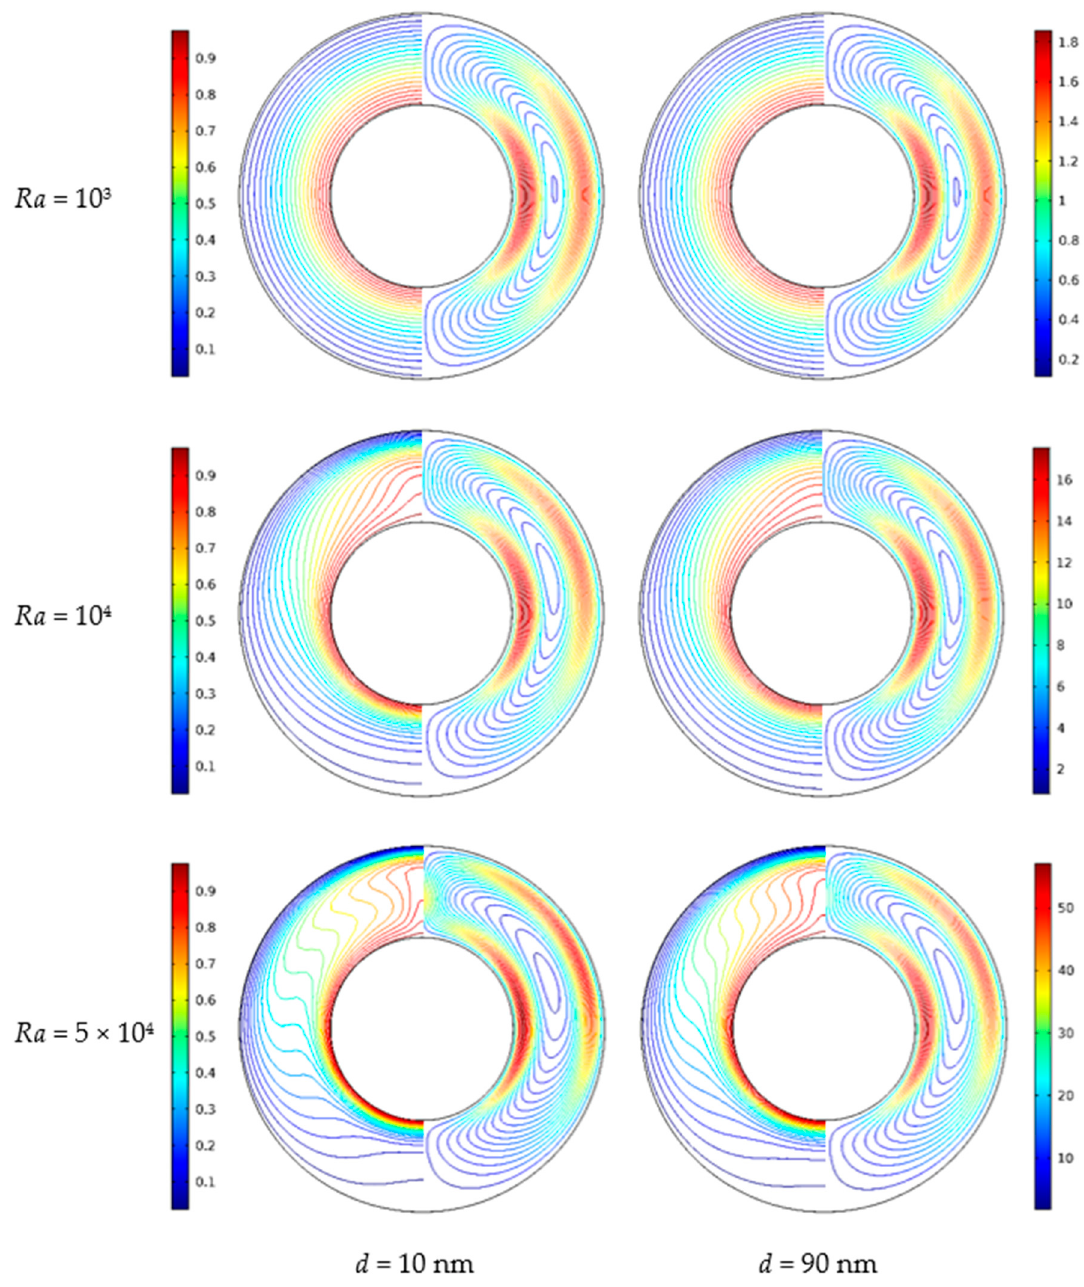
Figure 9. Isotherms (left) and streamlines (right) for Cu–water nanofluid for different nanoparticle diameters ( d sp ) and Rayleigh numbers ( Ra ) at Da = 10 − 2 , ϕ = 0.05, ε = 0.5, and RR = 2.